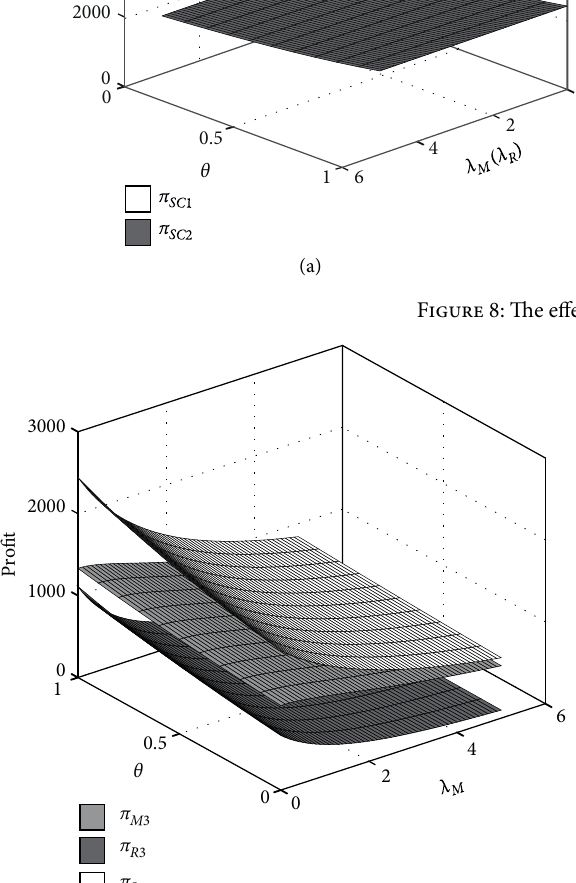
on 𝜋 , 𝜋 , and 𝜋 𝑀 푀3 푅3